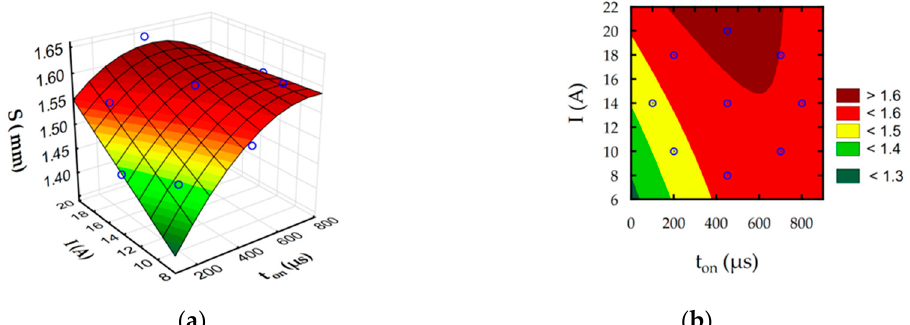
Figure 13. Estimated for slot width S: ( a ) response surface and ( b ) contour plot.